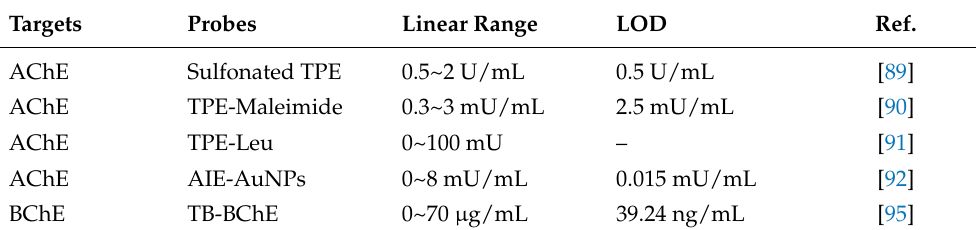
Table 4. Analytical performances of AIE-based methods for the detection of cholinesterases.